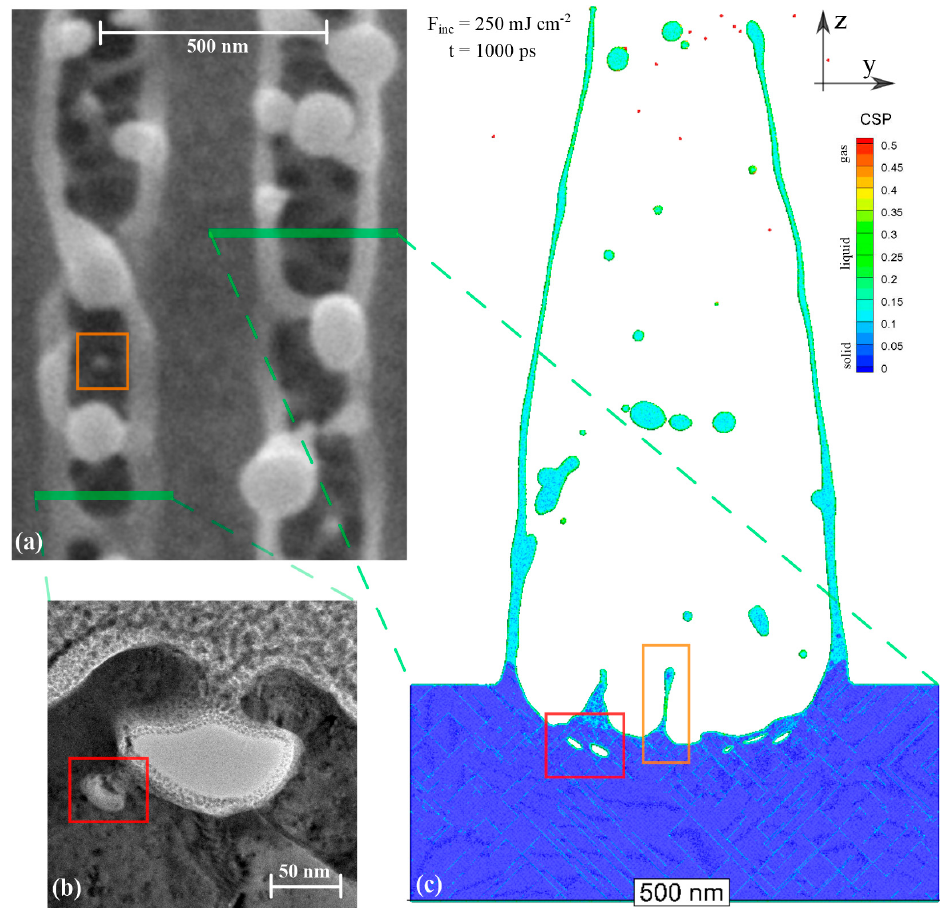
Figure 6. Direct comparison of SEM top view in ( a ) and TEM cross-section in ( b ) with the simulation results of the atomic configuration 40 x 500 x 200 nm 3 of a 500-nm period at 1000 ps in ( c ). The atoms are colored by CSP parameter. The process of spallation results in an opening of the generated structure and formation of a number of droplets and pillar-like structures on the remaining surface (orange rectangle). The spallation process is accompanied with the generation of subsurface voids (red rectangle) registered in both experiment and simulation and is magnified in the squared window in Figure 7d below.